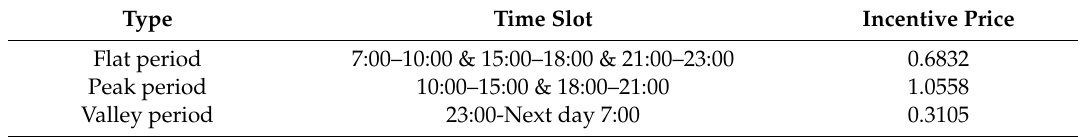
Table 8. Peak-Valley Time-of-Use Incentive Price (yuan /